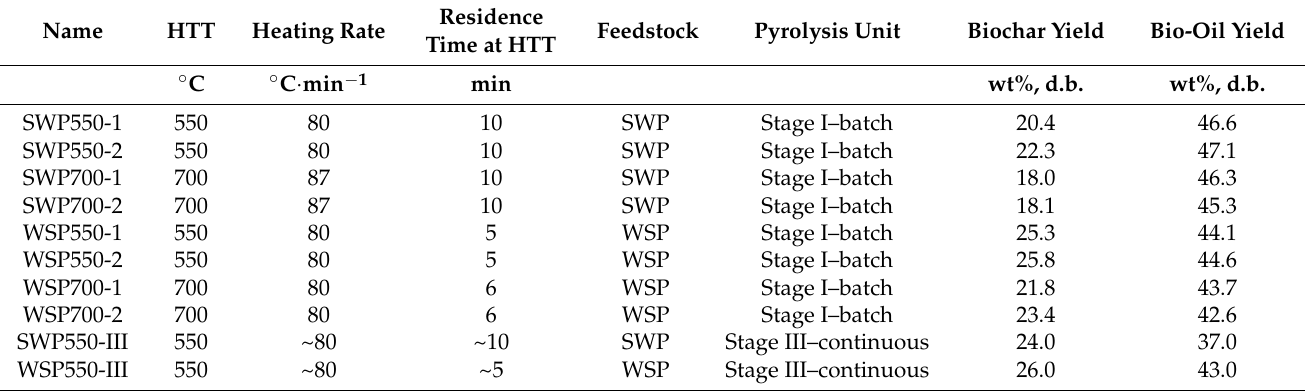
Table 1. Key characteristics of bio-oils production. All pyrolysis with the Stage I unit were performed in duplicates represented by ‘-1 (cid:48) and ‘-2 (cid:48) . HTT, highest treatment temperature; SWP, softwood pellets; WSP, wheat straw